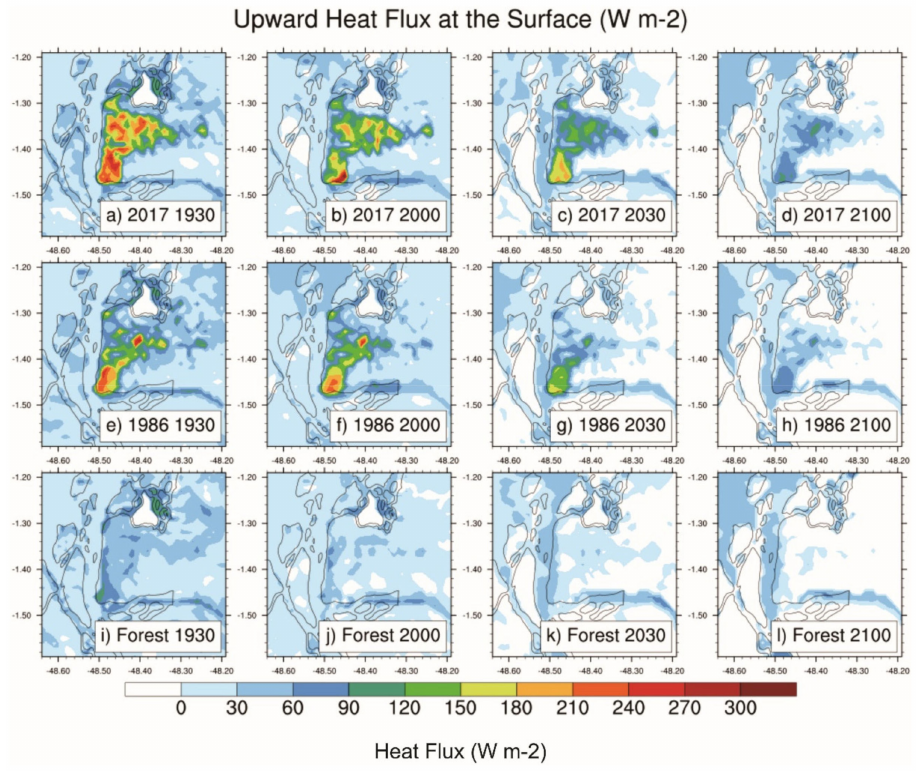
Figure 11. Upward heat fluxes (W m − 2 ) for each of the 2017 ( a – d ), 1986 ( e – h ), and forest ( i – l ) scenarios at 1930, 2000, 2030, and 2100 UTC.